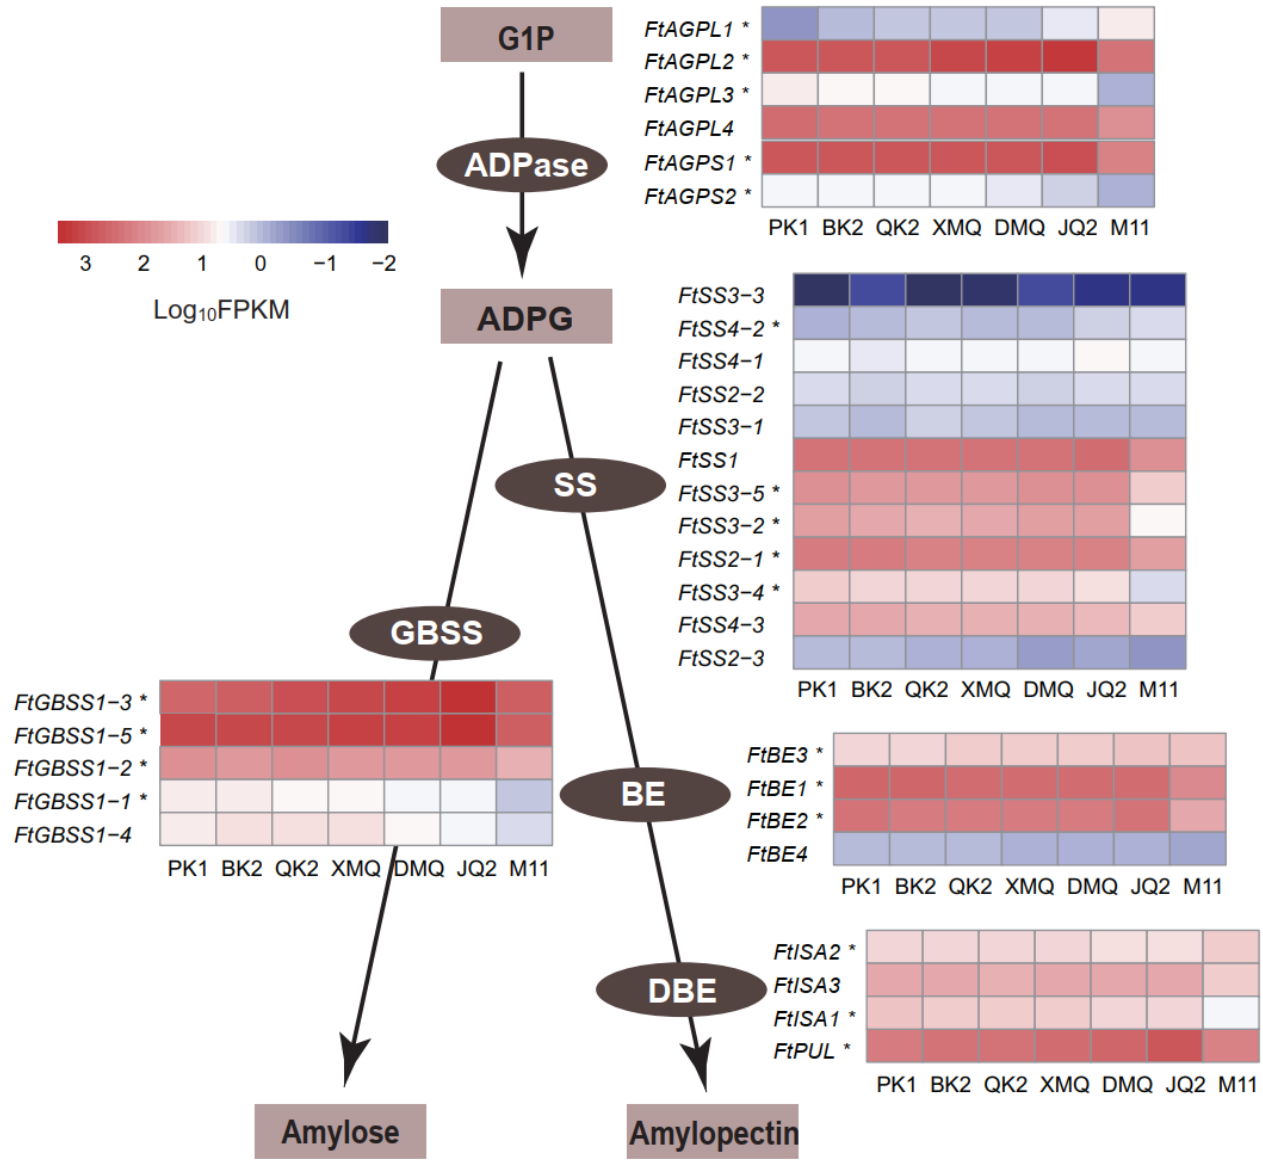
Figure 3. Expression patterns of genes related to the starch biosynthesis pathway. The light-brown rectangles and dark-brown ovals represent the substrates and the enzymes in the starch biosynthesis pathway, respectively. The heatmap shows the expression patterns of genes in the starch biosynthe- sis pathway. Genes marked with “*” were identified as DEGs. AGPase, ADP-glucose pyrophos- phorylase; AGPL, large subunit of AGPase; AGPS, small subunit of AGPase; GBSS, granule-bound starch synthase; SS, soluble starch synthase; BE, starch branching enzyme; DBE, starch